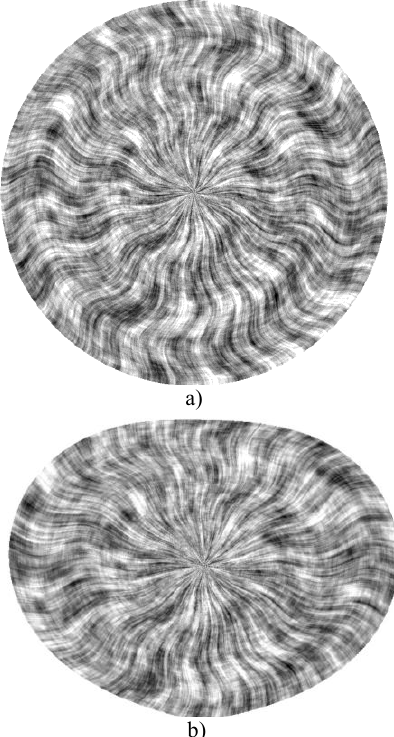
Figure 13. Simulation of deformed images: a) random angle, b) random angle and